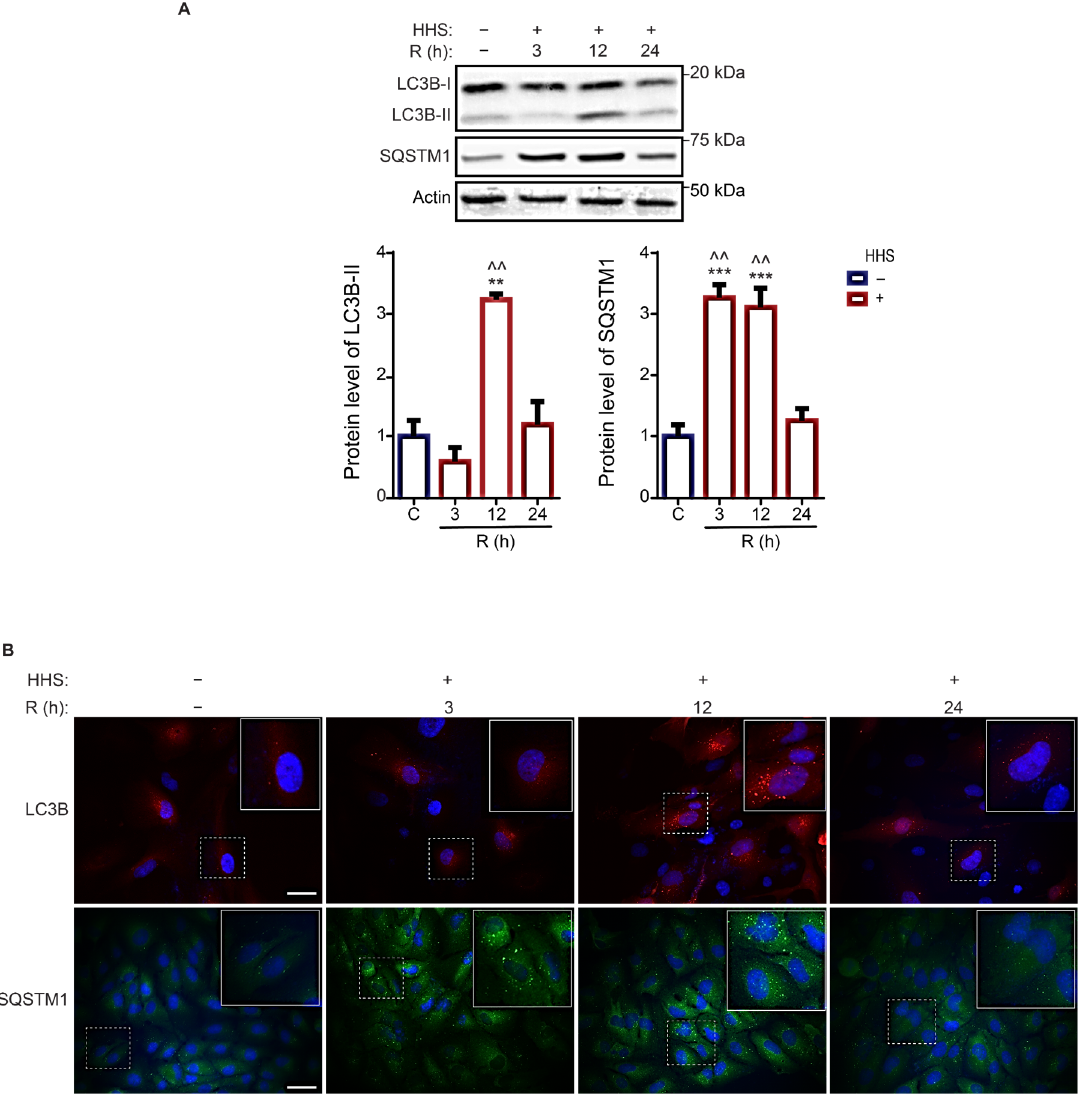
Figure 3. Hormetic heat shock increases expression of autophagosome-related proteins. ARPE-19 cells were treated without HHS (–) or with 30 min HHS (+) at 42 °C, followed by recovery at 37 °C. ( A ) Immunoblot quantitative analysis of the LC3B-II and SQSTM1 levels was corrected to Actin as a loading control. ( B ) Immunofluorescence analysis was shown for the puncta of LC3B (red) and SQSTM1 (green). Cells’ nuclei counterstained blue with Hoechst. C stands for control (non-HHS). R shows the post-HHS time of recovery at 37 °C. Data are represented as mean ± SEM ( n = 3). Statistical analysis was used by one-way ANOVA followed by Bonferroni‘s multiple comparisons (** p < 0.01 and *** p < 0.001 vs. C, ^^ p < 0.01 vs. 24). Scale bar = 20 μ m.